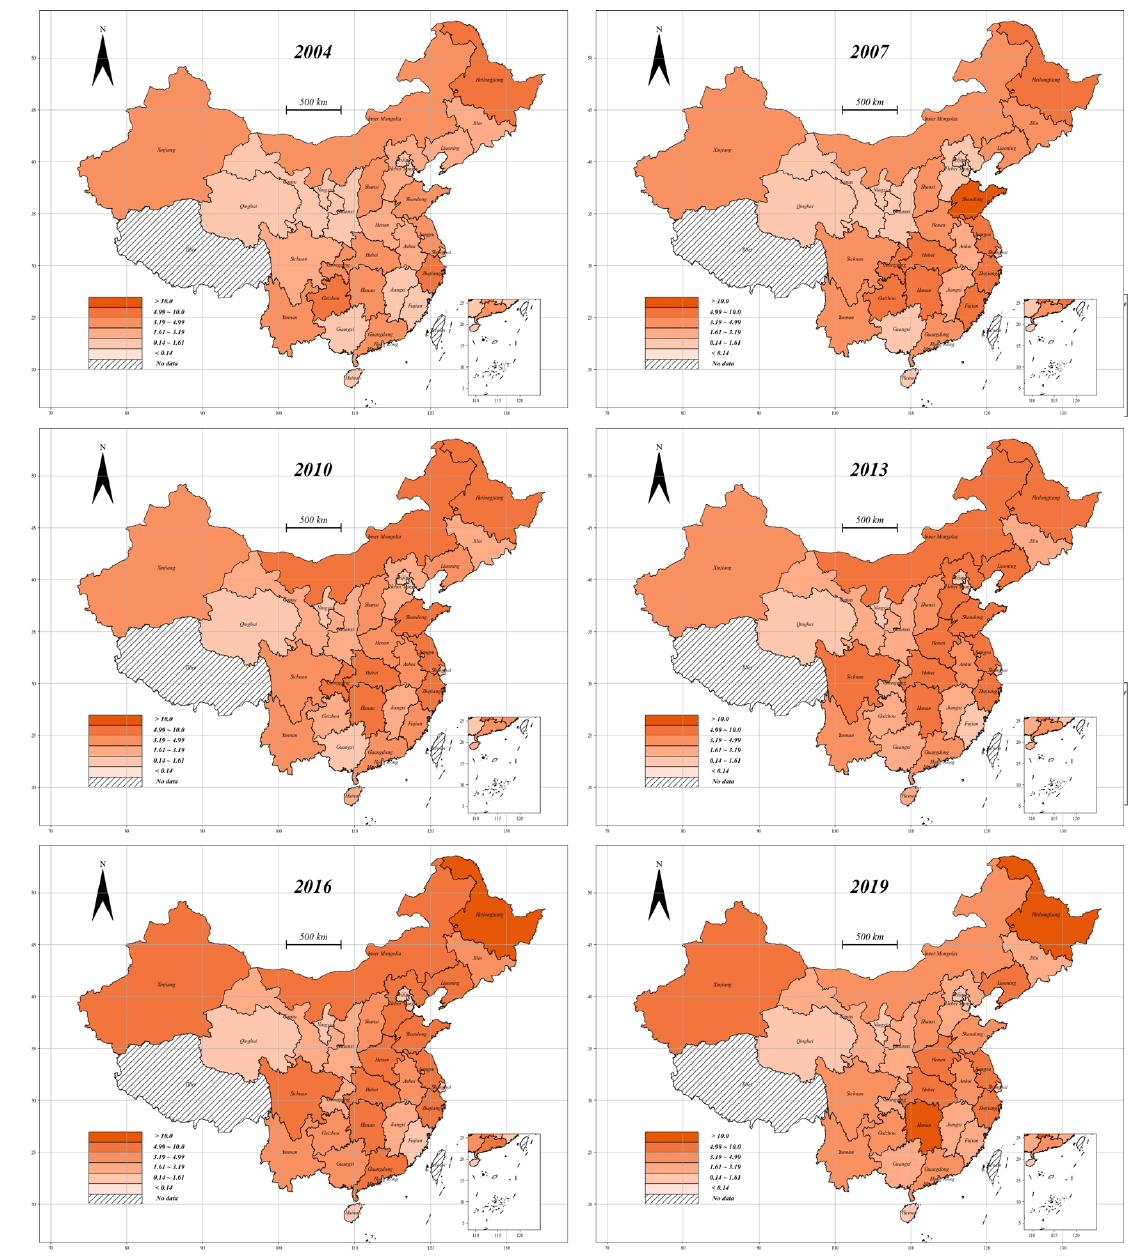
Figure 2. Spatial distribution of agricultural carbon emissions in China (unit: